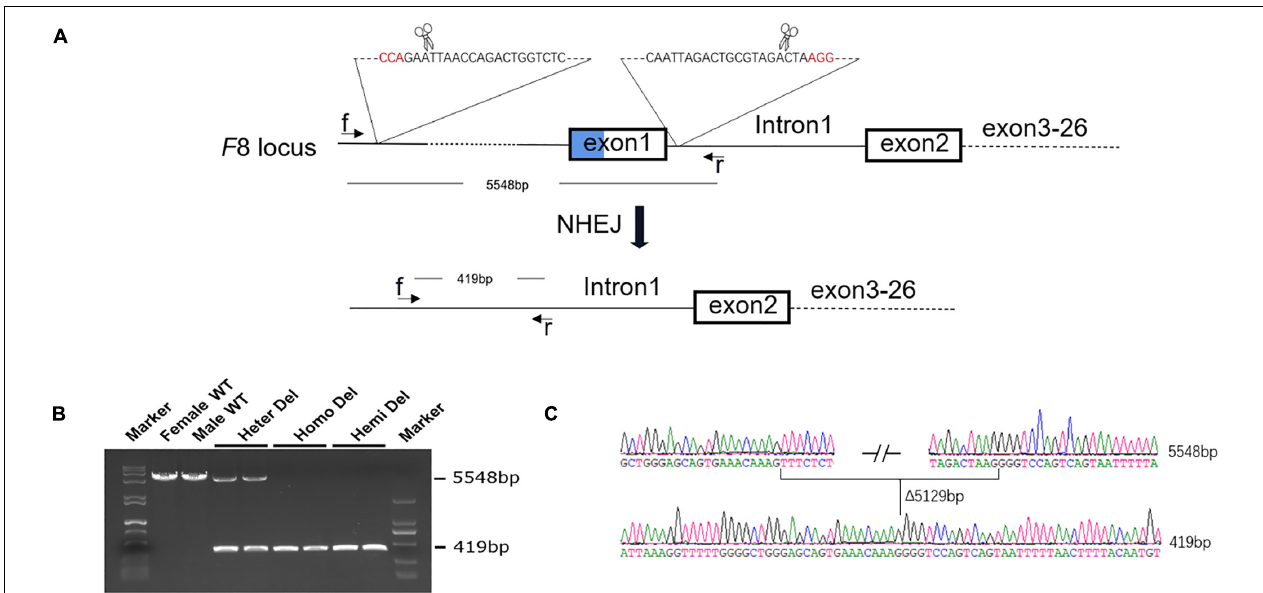
FIGURE 1 | Generation of an HA mouse model. (A) Schematic diagram of the strategy for F8 knock out. Two sgRNAs targeting intron 1 of F8 and ∼ 5 kb upstream to the transcription start site, respectively, were designed. A 5,129-bp fragment, including exon 1 and the promoter region, was excised from the genome. (B) PCR analysis for detection of the deletion. Using the primers f and r in the schematic, a 5548-bp fragment was amplified from the WT genome. After deletion, the PCR product was 419 bp in length. Both PCR products could be amplified from the female with only one allele deleted. (C) Sanger sequencing confirmed the deletion and showed no indels formed in the junction. WT, wild type; Heter Del, heterozygous deletion; Homo Del, homozygous deletion; Hemi Del, hemizygous deletion.